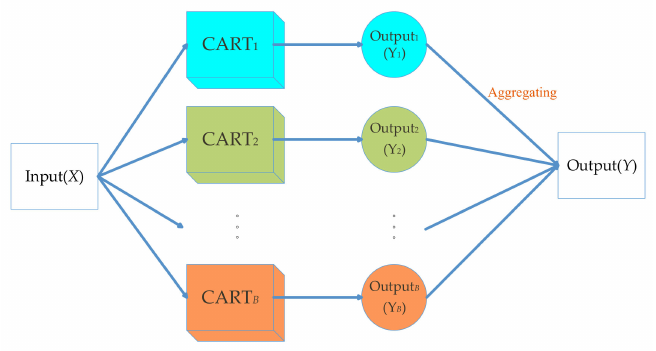
Figure 4. Prediction process of the Random Forests